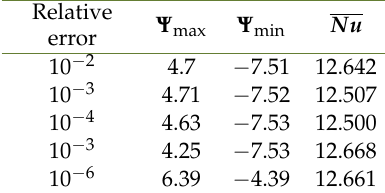
Table 2. Testing for Ψ max , Ψ min ,Nu at different relative error for counter of streaming Ω = 200 and Ra = 10